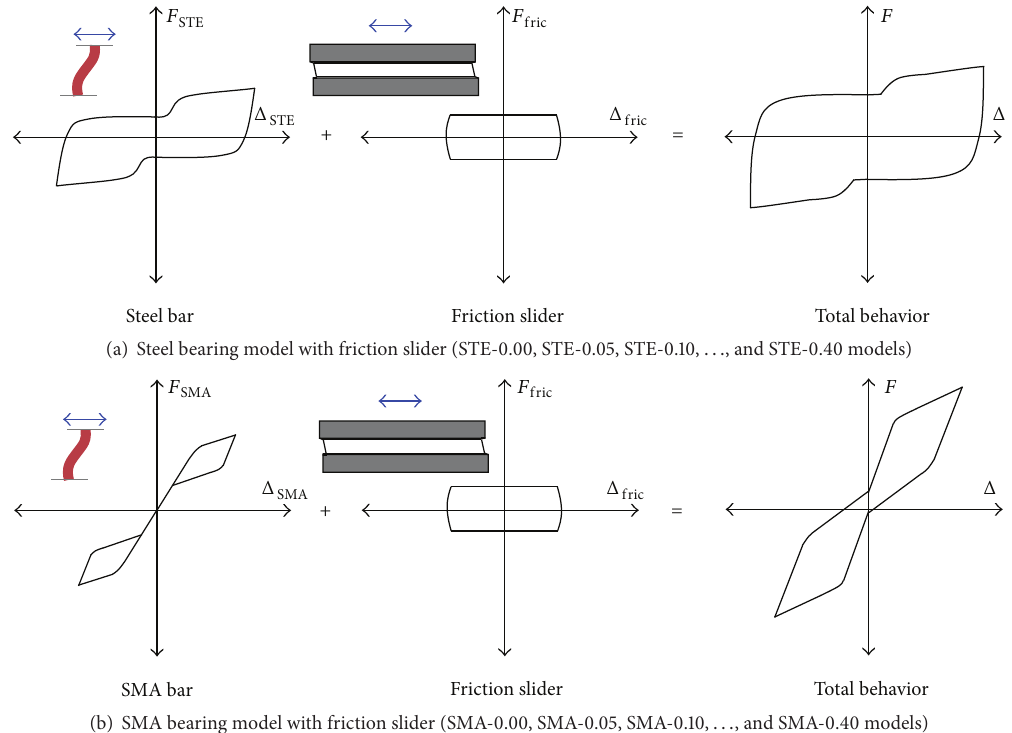
Figure 5: Response mechanism of the bridge